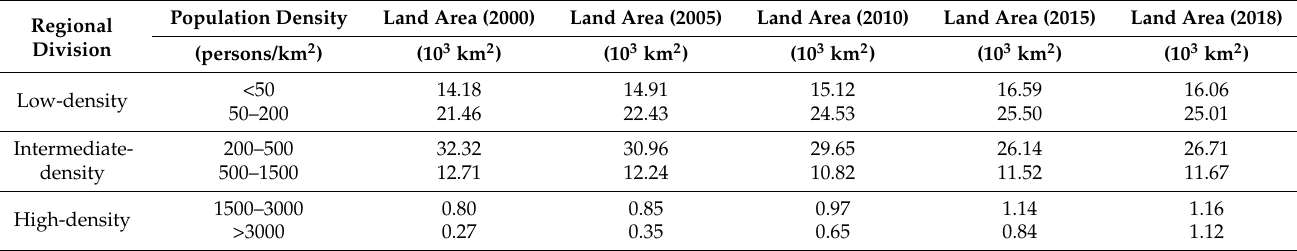
Table 5. Changes in population density from 2000 to